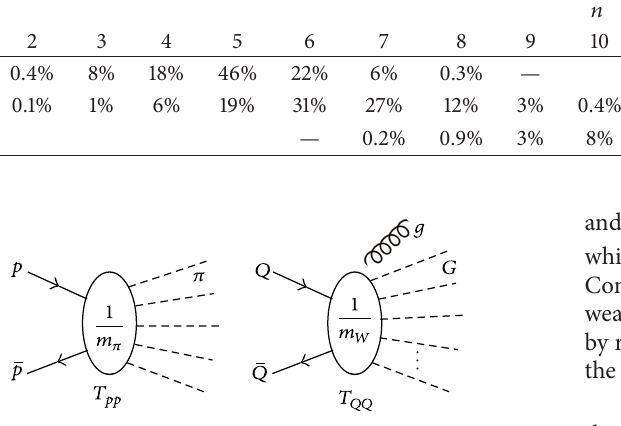
Figure 8: Illustration for 𝑝𝑝 → 𝑛𝜋 for 𝑛 = ⟨𝑛 𝜋 ⟩ ≅ 5 and the analog of 𝑄𝑄 → 𝑛𝐺 , where 𝐺 = 𝑉 𝐿 is the Goldstone boson of EWSB. Depending on 𝑚 𝑄 = 1 - 2 GeV, ⟨𝑛 𝐺 ⟩ could go from 6 to 12 (see (58) and Table 1). The gluon line indicates the relatively soft shedding of